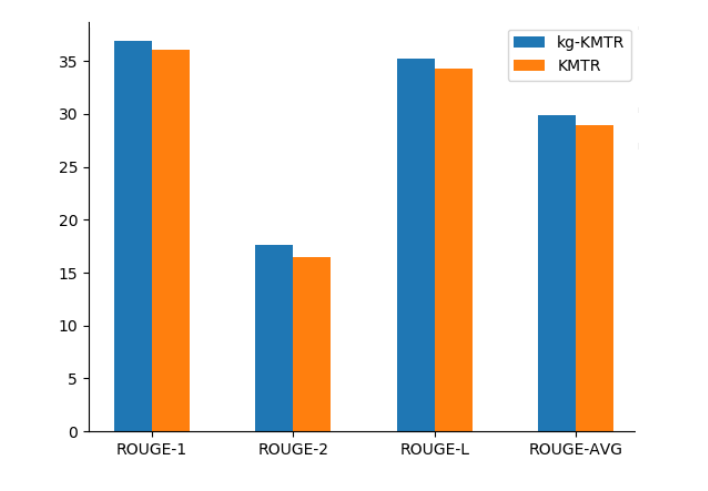
Figure 4. Performance comparison of kg-KMTR and KMTR.